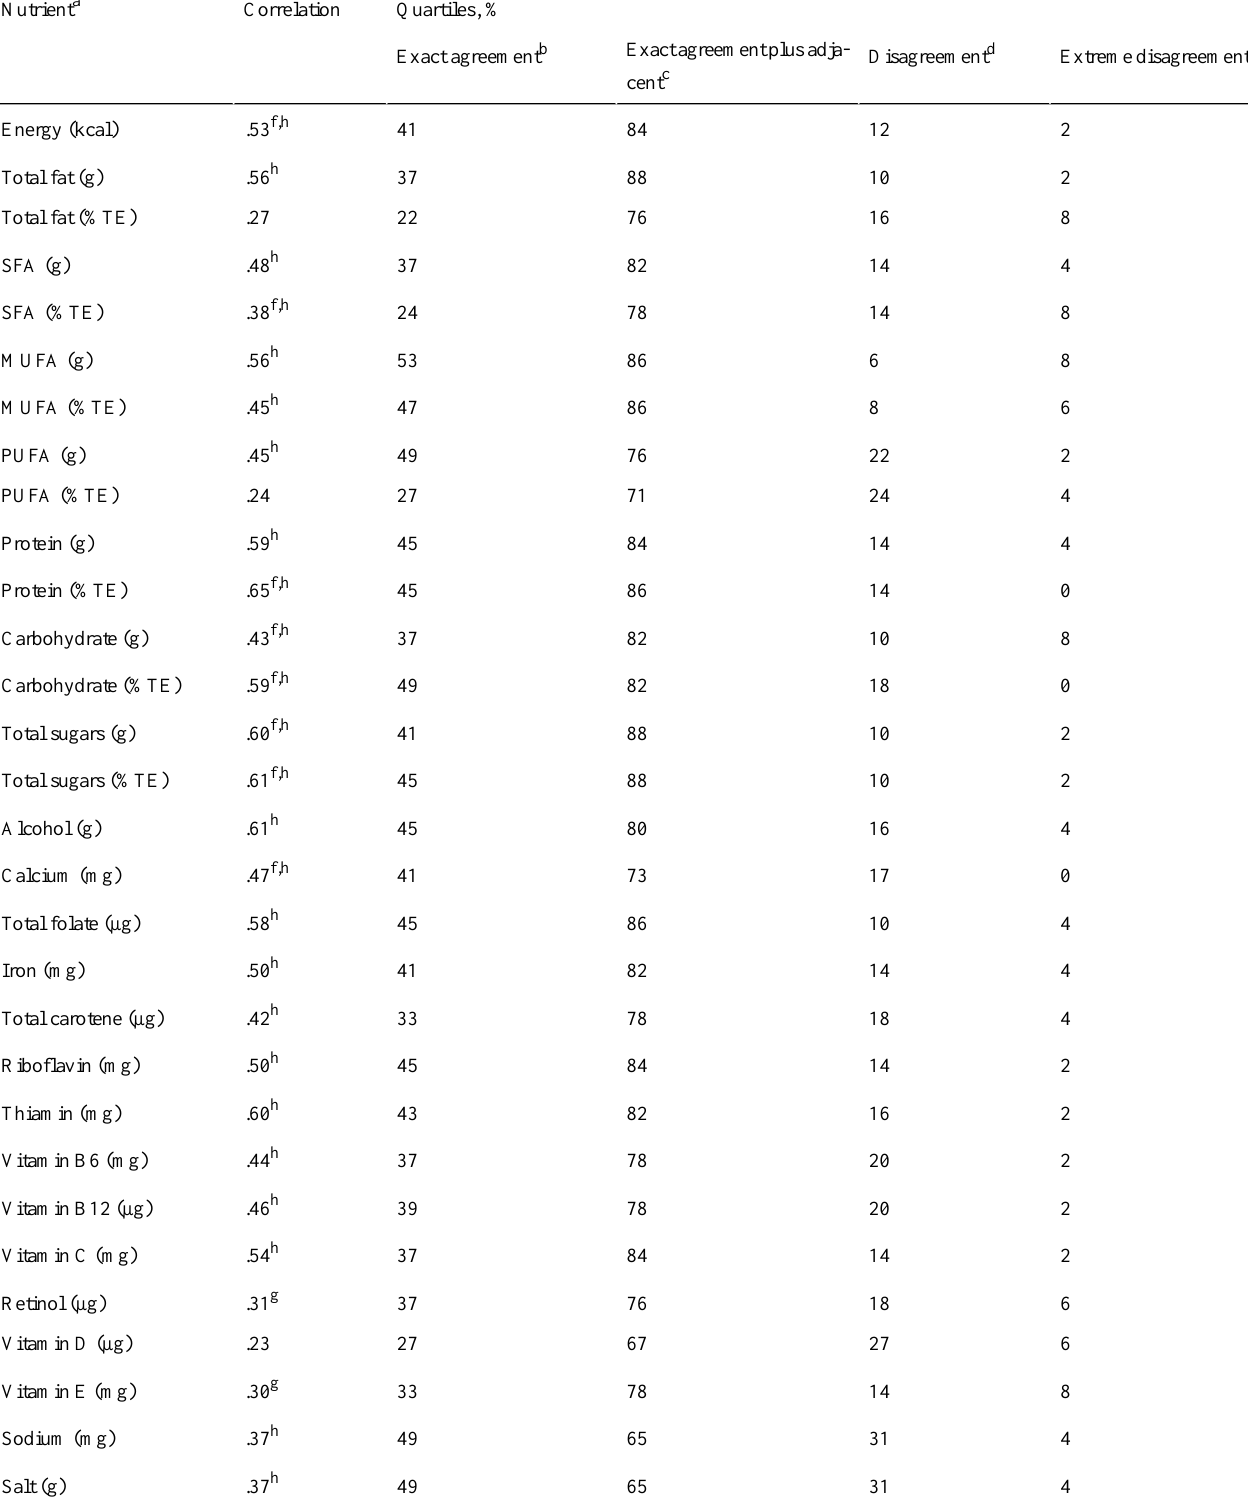
Table 6. Unadjusted correlation coefficients and cross-classification of quartiles of mean energy and nutrient intakes derived from the online Food4Me FFQ and 4-day WFR